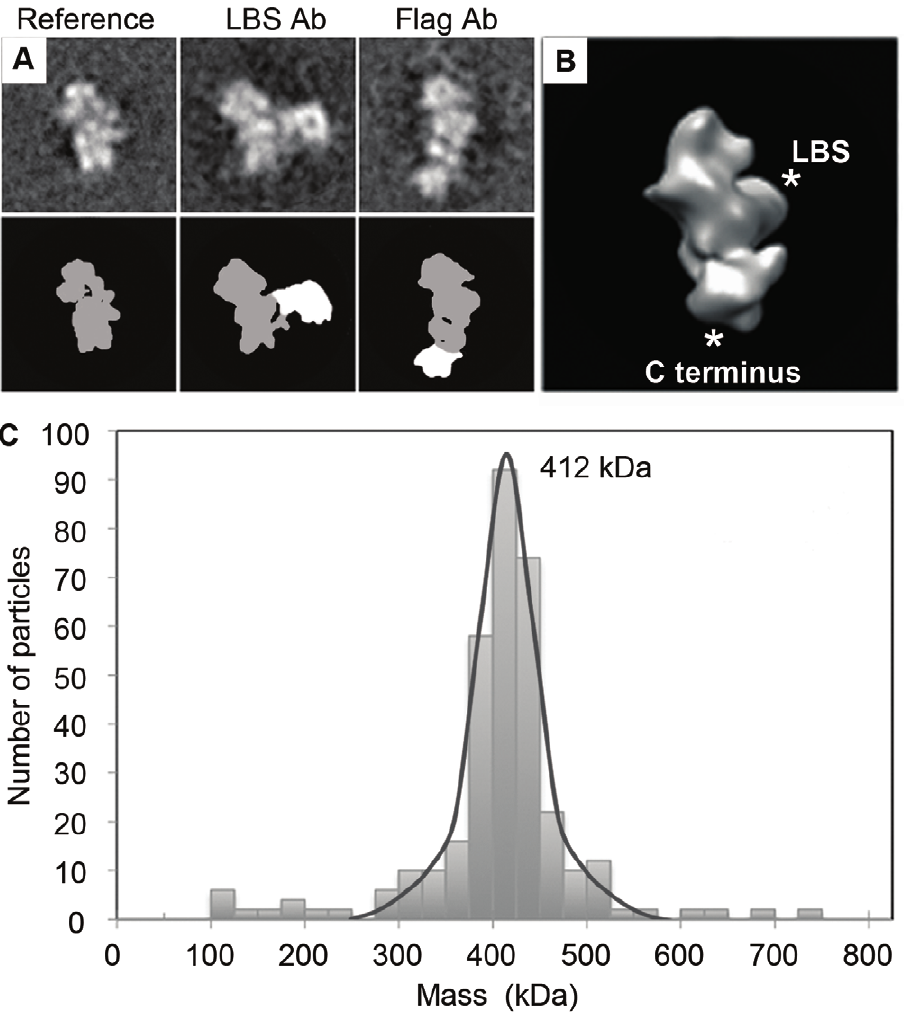
Figure 3. Characterization of the Drosophila NECD. ( A ) Projection averages (top row) and schematic representations (bottom row) of the NECD labeled with antibodies specific for the ligand-binding site (LBS Ab) and for the Flag tag (Flag Ab) in comparison with the corresponding average of unlabeled NECD (Reference). The side length of the individual panels is 43 nm. ( B ) EM density map of Drosophila NECD showing the positions of the ligand-binding site (LBS) and the membrane-insertion site (C terminus) deduced from the antibody labeling. ( C ) Histogram indicating the mass distribution of particles imaged by STEM.